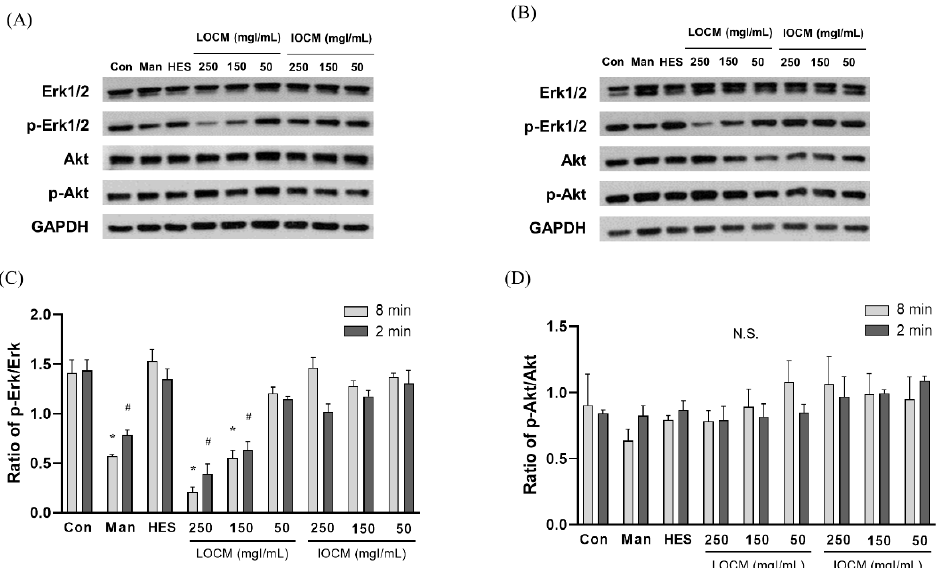
Figure 5. Representative immunoblots of Akt, p-Akt, Erk1/2, p-Erk1/2, and β -actin at ( A ) a rocker interval of 8 min and ( B ) a rocker interval of 2 min. ( C ) Ratio of p-Erk1/2/Erk1/2. ( D ) Ratio of p-Akt/Akt. Data are represented as the mean ± SEM. * p < 0.05 versus control of 2 min interval, # p < 0.05 versus control of 8 min interval. LOCM—low-osmolar contrast media; IOCM—iso-osmolar contrast media; Con—control; Man—mannitol; HES—hydroxyethyl starch; N.S.—nonsignificant.